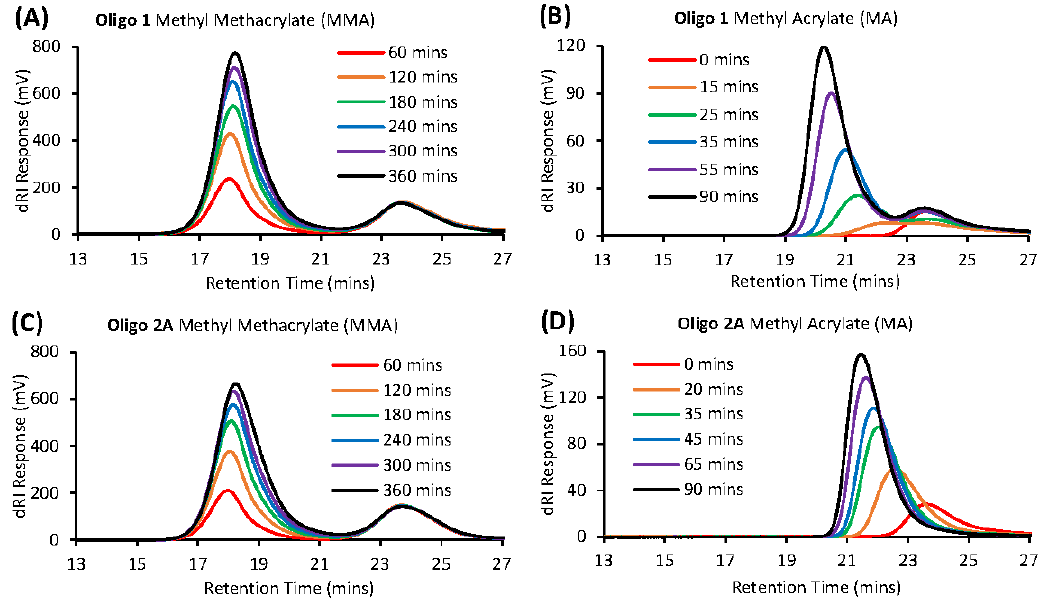
Figure 7. Gel permeation chromatography (in THF) traces for macro-RAFT co-oligomer solution polymerizations in DMF ( A ) Oligo 1 + MMA, ( B ) Oligo 1 + MA, ( C ) Oligo 2A + MMA and ( D ) Oligo 2A + MA.